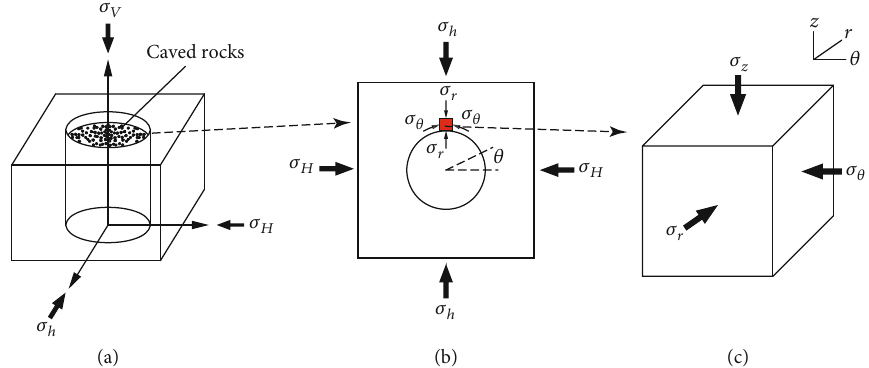
Figure 2: Coordinates ’ transformation from in situ stress ( σ in polar system ( θ , z , r ). (a) Three-dimension (3D) view of the caved space. (b) Local stress at the surrounding rocks in the cross section of caved space. (c) An element illustrating the local stress at surrounding